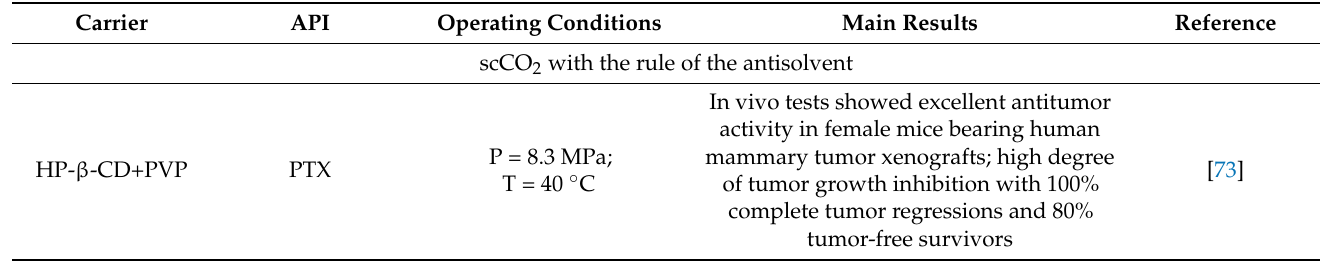
Table 3. Coprecipitated nanoparticles. 5-FU = 5-Fluorouracil; AO/EB = acridine orange/ethidium bromide; BSA = bovine serum albumin; CPT = Camptothecin; DXT = dextran; HCPT =